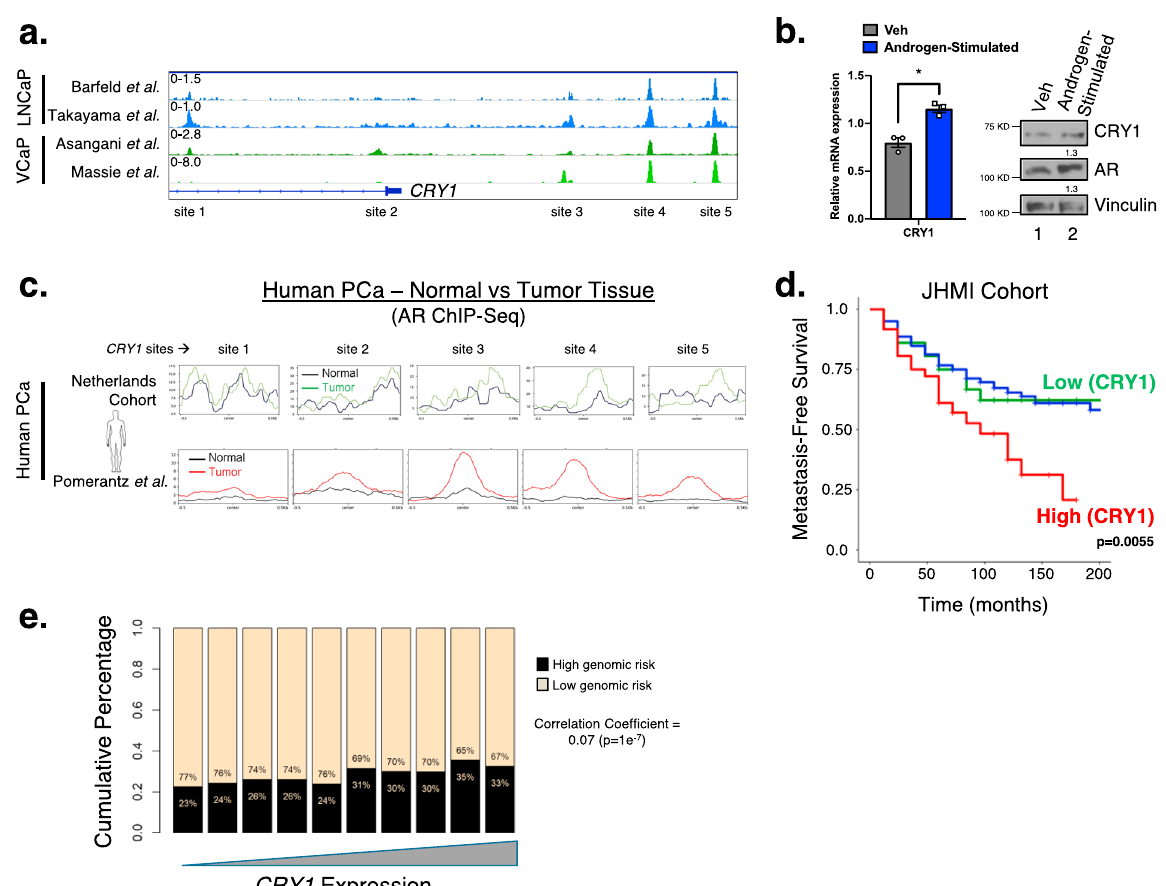
Fig. 1 CRY1 is induced by androgens and associated with poor outcome. a AR binding sites on CRY1 in several PCa datasets, including in Barfeld et al. 2017, Takayama et al. 2018, Asangani et al. 2014, and Massie et al. 2011. Genomic traces showing AR binding sites on CRY1. b C4-2 cells in hormone- deprived media (Veh) for 48 h and treated with 10 nM DHT for 16 h (Androgen-Stimulated). Cells were harvested for RNA ( CRY1 and 18 S ) and protein (CRY1, AR, and Vinculin). c AR binding sites on CRY1 in human tissue comparing normal and tumor samples from a cohort of PCa patients in the Netherlands from Dr. Wilbert Zwart and Pomerantz et al. 2015 dataset. d In the JHMI retrospective cohort, patient samples were split into groups based on CRY1 expression into top 10% vs middle 80% vs low 10%. Patients with high (top 10%) CRY1 expression are associated with poor metastatic outcome. e CRY1 expression was compared to the high Decipher 5239 prospective radical prostatectomy samples. N = 3 independent experiments. Data are presented as mean values ± SEM and analyzed using Student ’ s t -test (* p < 0.05). Statistical signi fi cance was evaluated at 0.05 alpha level